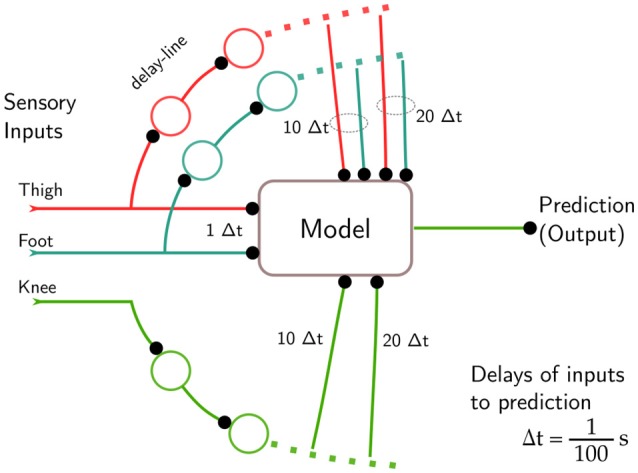
Gait detection tries to minimize the prediction error for sensory inputs s→t by choosing an appropriate model. Delay lines provide a history H of sensory inputs, which is fed into a feed-forward model predicting a single value in the next time step, here the knee. The delay relative to the predicted signal is given as a multiple of the sampling interval 1100 s. For the predicted channel, the current input is not fed in, as experiments showed a high probability of the network to choose it as the best prediction.